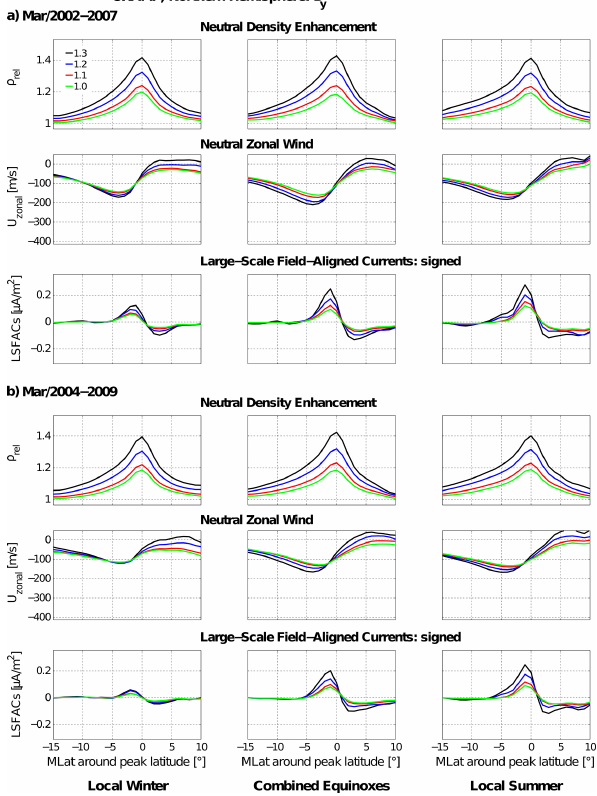
Fig. 6. The same as Fig. 4 but for the negative IMF B y